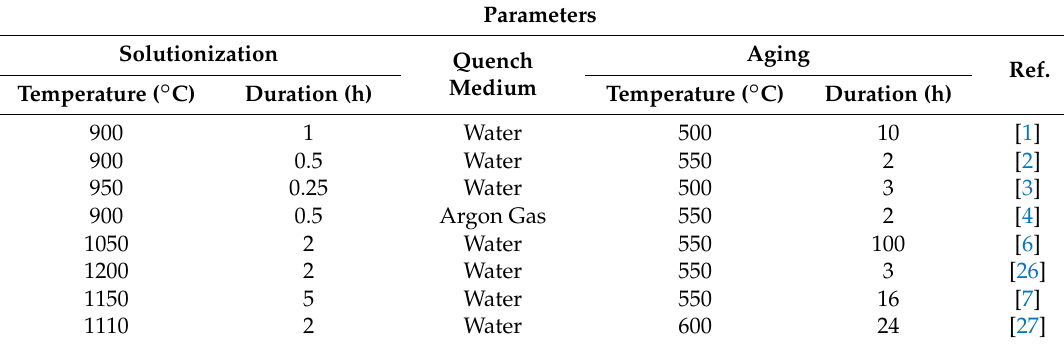
Figure 1. A schematic showing the general processing routes for the incorporation of precipitates in steels through high temperature solutionization, followed by quenching and a subsequent aging at a relatively lower temperature. Table 1. Some parameters used to incorporate precipitates in steels through high temperature solutionization, followed by quenching and a subsequent aging at a relatively lower temperature.